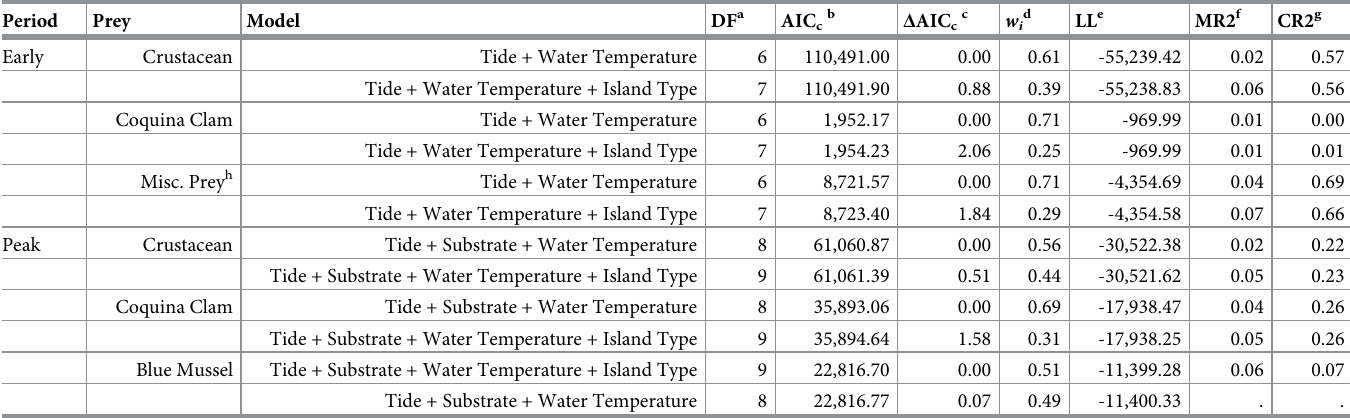
Table 3. Most parsimonious generalized linear mixed-effects regression models ( Δ AIC c < 4) predicting crustacean, coquina clam, and miscellaneous prey abun- dances (organisms/m 2 ) captured in 10 cm diameter x 3.5 cm deep cores on peat substrate early in red knot migration (May 14–20, 2008–2018; n = 457; ‘early’) and on sand and peat substrate at the approximate peak of red knot migration (May 21–27, 2007–2018; n = 1,322; ‘peak’), Virginia’s barrier islands. All models con- tained “Island” and “Year” as random